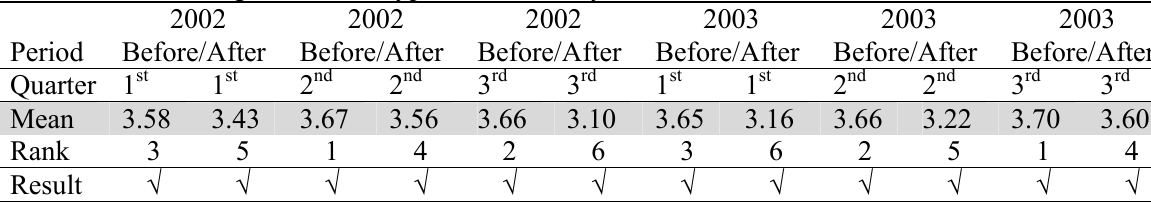
The results of testing the second hypothesis for the years of 2004-2005 2004 2004 Period Before/After Before/After Before/After Before/After Before/After Before/After Quarter Mean Rank Result